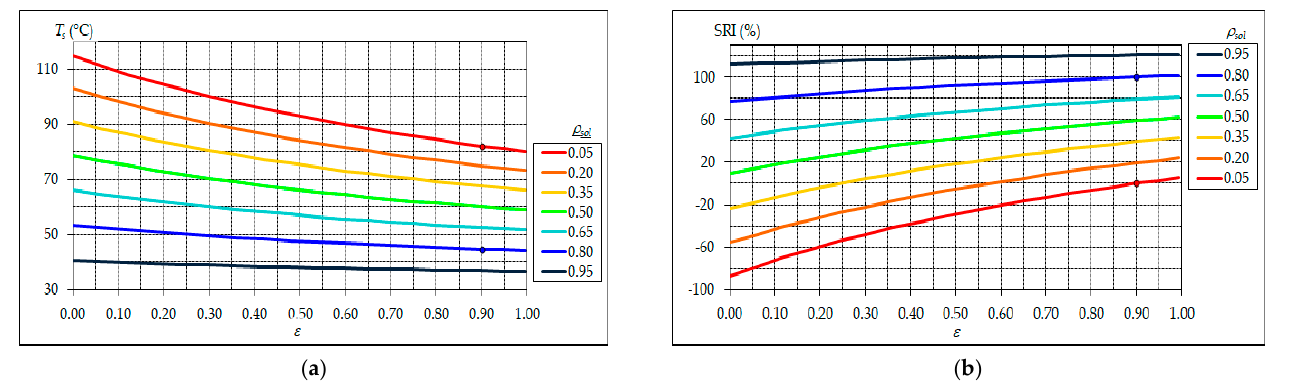
Figure 3. Surface temperature ( a ) and SRI ( b ) for reference ambient conditions and convection coefficient h c = 12 W/(m 2 K), as a result of intermediate wind speed (i.e., between 2 and 6 m/s); blue and red dots are for the reference white ( ρ sol,w = 0.80, ε w = 0.90) and black ( ρ sol,b = 0.05, ε b = 0.90) surfaces, respectively.